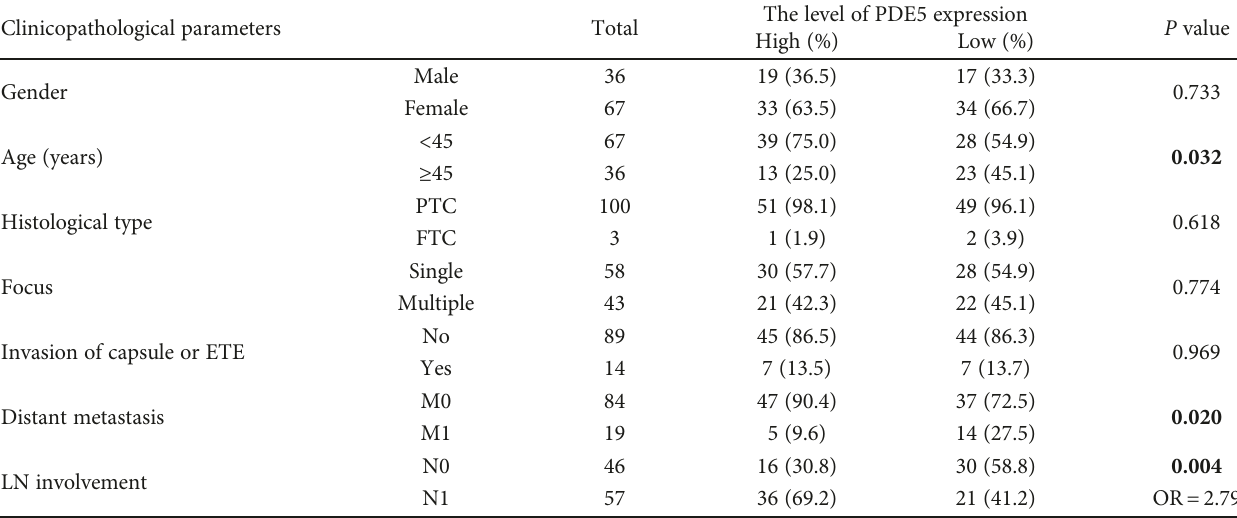
Table 2: Correlation between PDE5 expression and clinicopathological features.